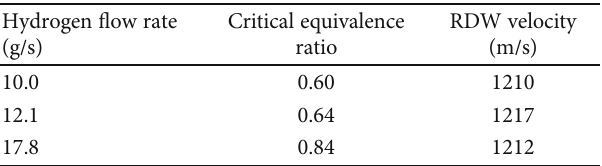
11: Schematic of generation mechanism of